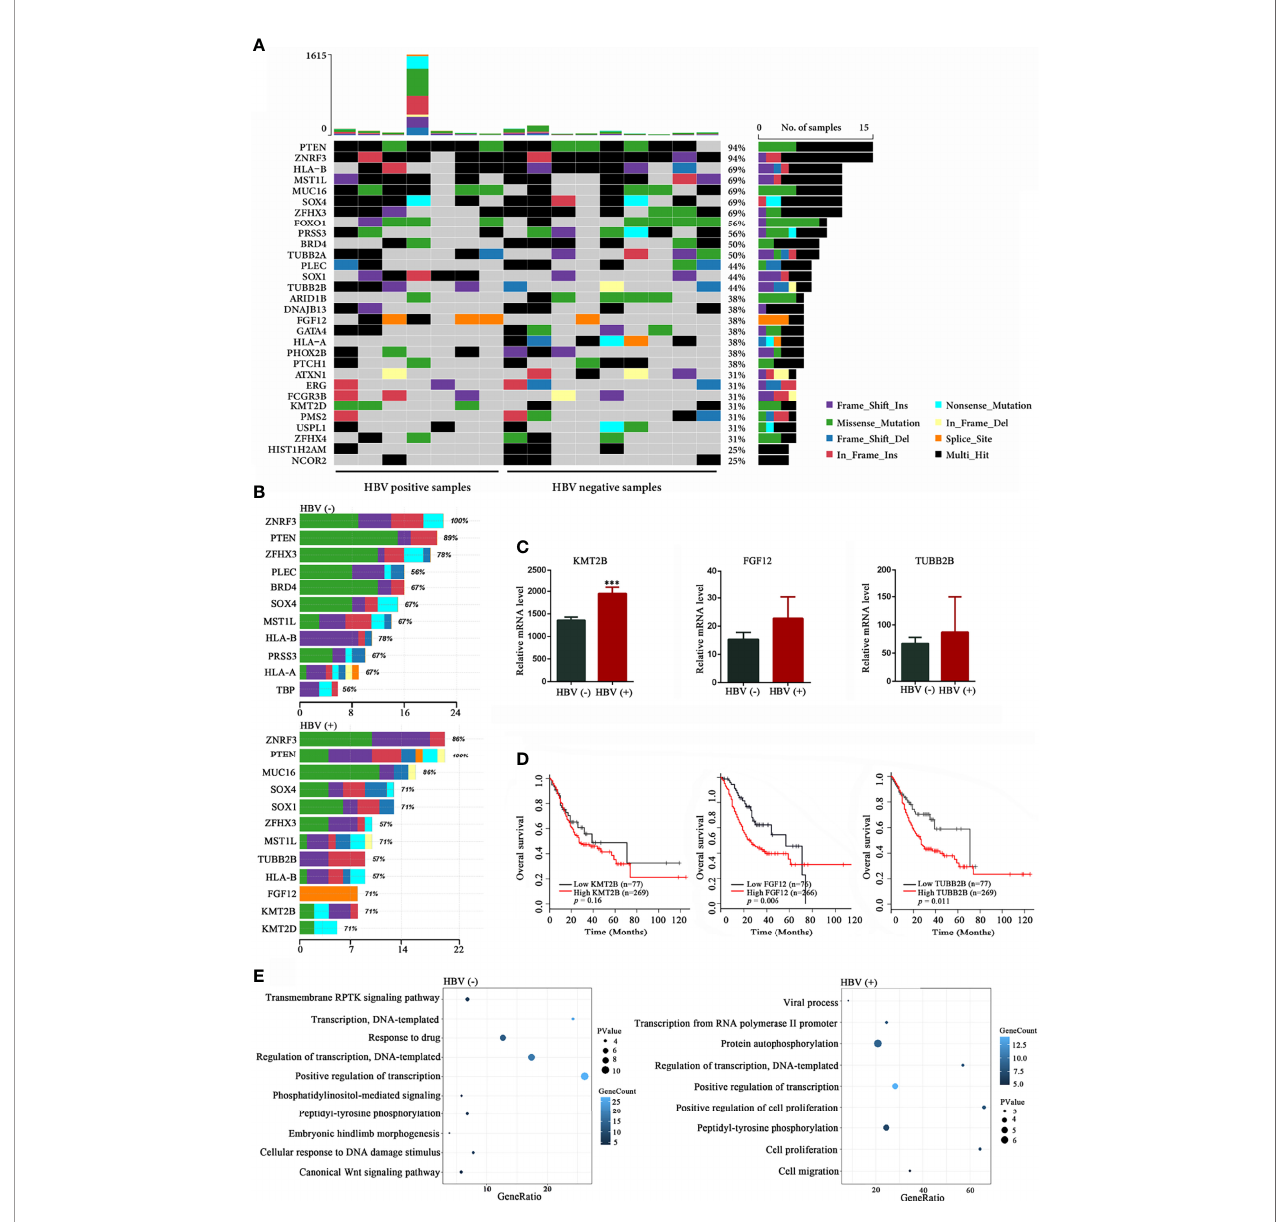
FIGURE 3 | Mutational signatures in HBV-positive and HBV-negative samples. (A) Genetic pro fi les of seven HBV-positive and nine HBV-negative gastric cancer (GC) samples. (B) Comparison of the most frequently mutated genes between the HBV-positive and HBV-negative GC samples. (C) Expression analysis of KMT2B , FGF12 , and TUBB2B in 32 pairs of GC and non ‐ tumor tissues from The Cancer Genome Atlas (TCGA) database. (D) Overall survival based on the expression levels of KMT2B , FGF12 , and TUBB2B in 346 patients with GC from TCGA database by Kaplan-Meier curves analysis; (E) Gene Ontology annotation analysis of frequently mutated genes in GC (mutation frequency ≥ 2, P < 0.05). HBV, hepatitis B virus; HBV-positive, positive for HBsAg or anti-HBs, anti-HBe, and anti-HBc; HBV- negative, negative for HBsAg, HBeAg, anti-HBe, anti-HBs, and anti-HBc. *** P <